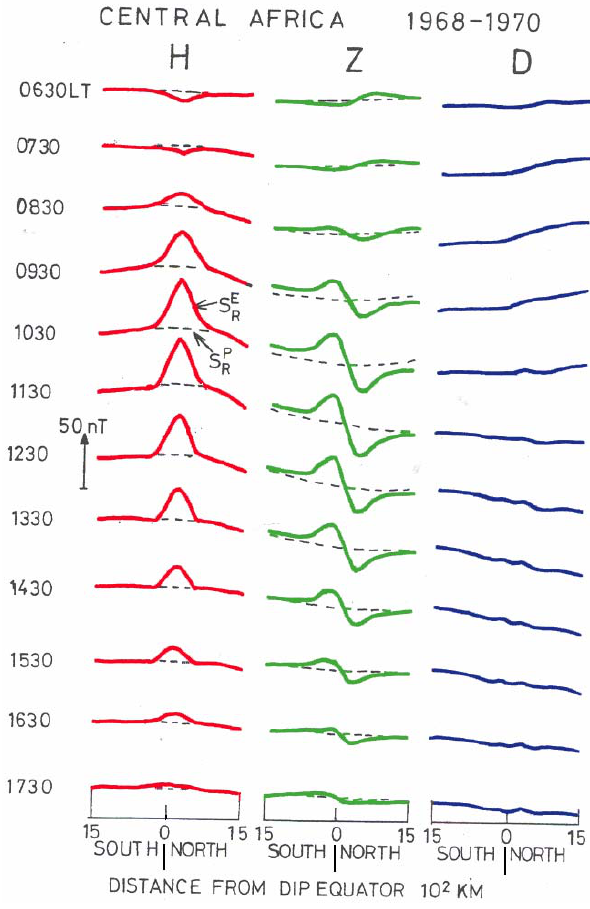
Fig. 13. Variations with geographic latitude of the magnetic field components H, Z and D in 46 ◦ W geographic longitude sector (after Fambitakoye and Mayaud,